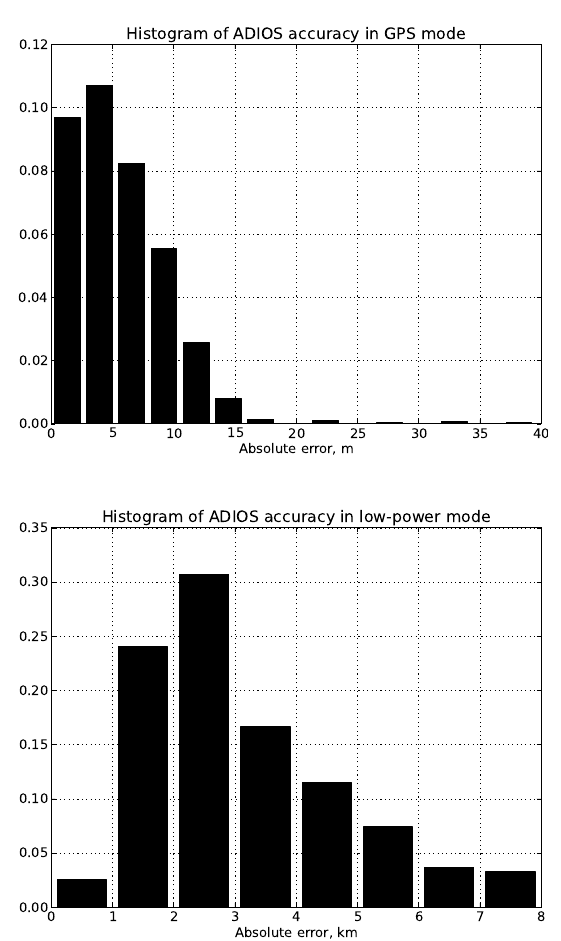
Figure 6. Accuracy of position measurements in GPS and low- power operating